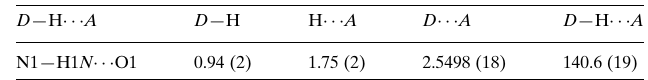
Hydrogen-bond geometry (A˚ , (cid:3)